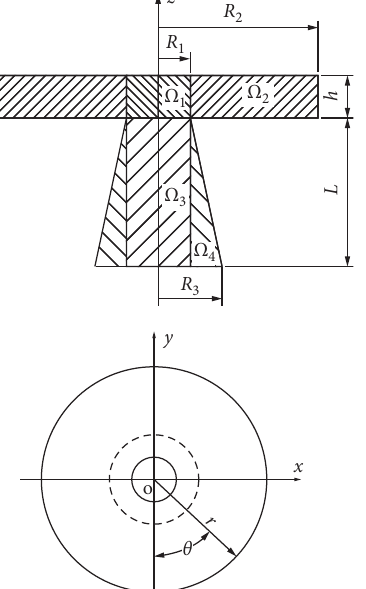
Figure 1: The simplified model of the horn-gear system having circular cross-section with its cylindrical coordinate system ( r, θ , z ) .